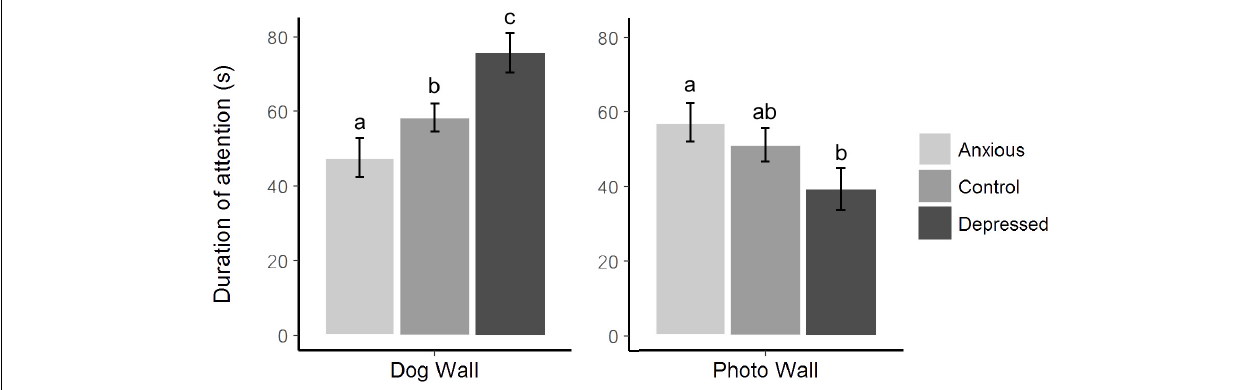
TABLE 4 | Mean, minimum, and maximum values for behaviors of sheep during Phase 2 of the pilot study, during the attention bias test. Statistic Sniff photo latency (s)